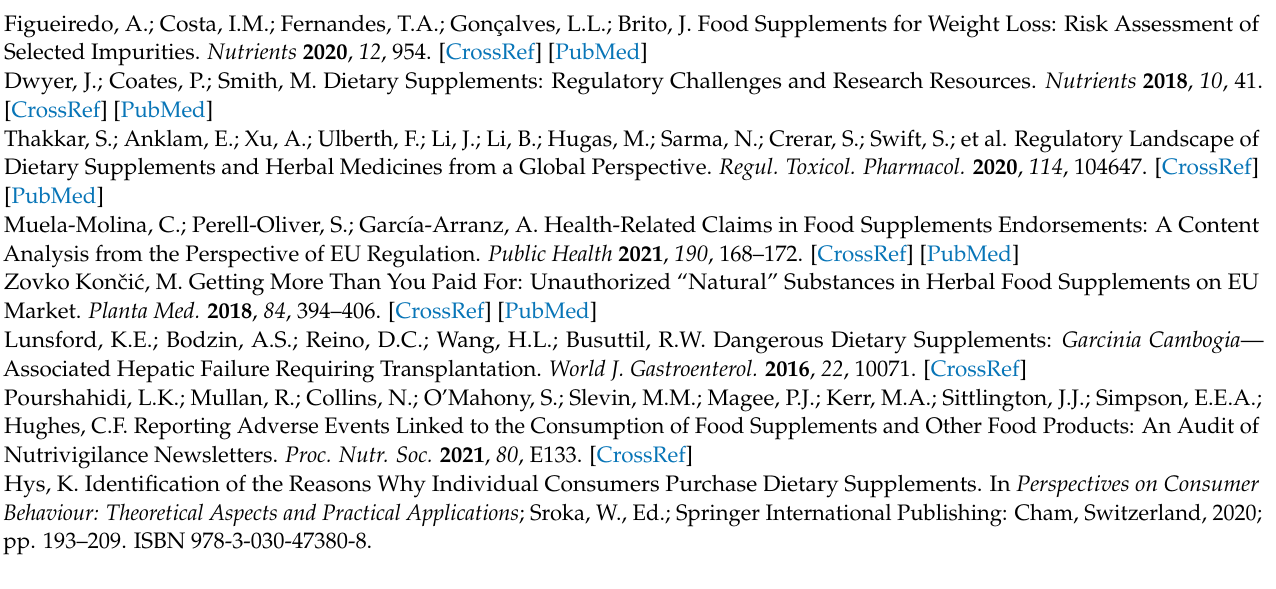
Figure A37. Percentage of products containing vitamin D in individual quarters in the period from 2012 to 28 November 2021. Joinpoints mark trend turning points. The date above the observation indicates the moment of publication of the scientific opinion/resolution.